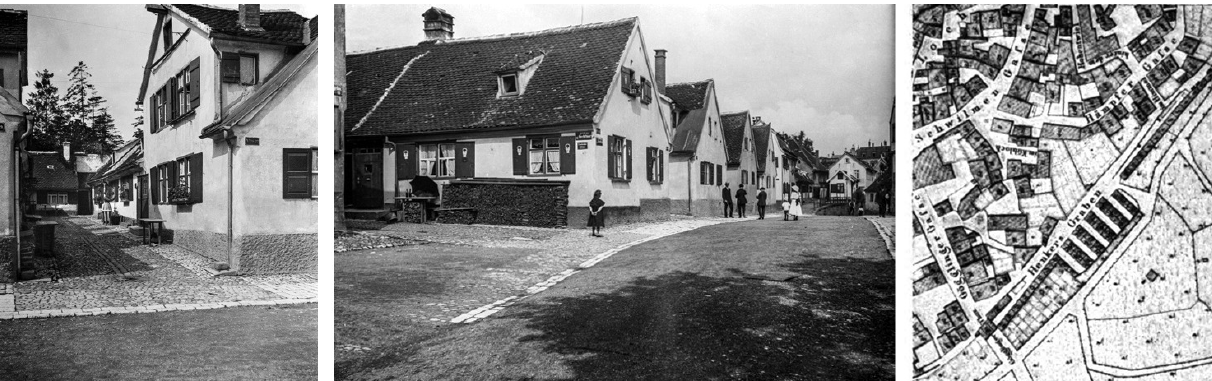
Figure 4. Left and center: Photographs of Ulm’s militia housing quarter from the collection of Franz Stoedtner. Right: Map highlighting Ulm’s militia housing on the border of the city wall. Sources: “Soldatenhäuser” [Soldiers’ Housing] (1900, © Bildarchiv Foto Marburg) and Kuhn (1921, p. 105).